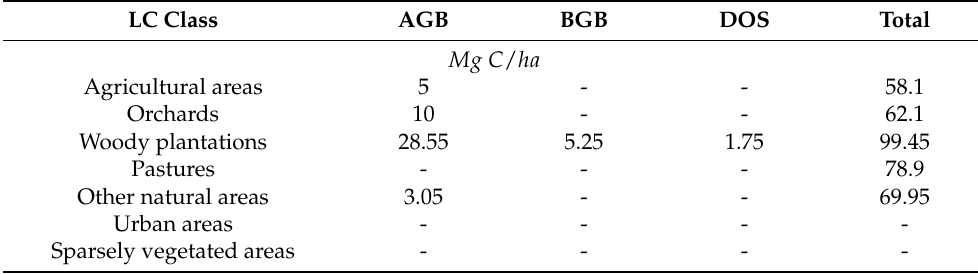
Table 8. Carbon content for land cover